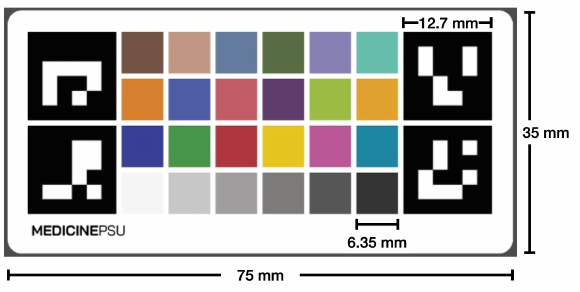
Figure 2. The calibration chart consists of four ArUco markers for the automatic detection and the Macbeth chart of 24 square color patches for color calibration.